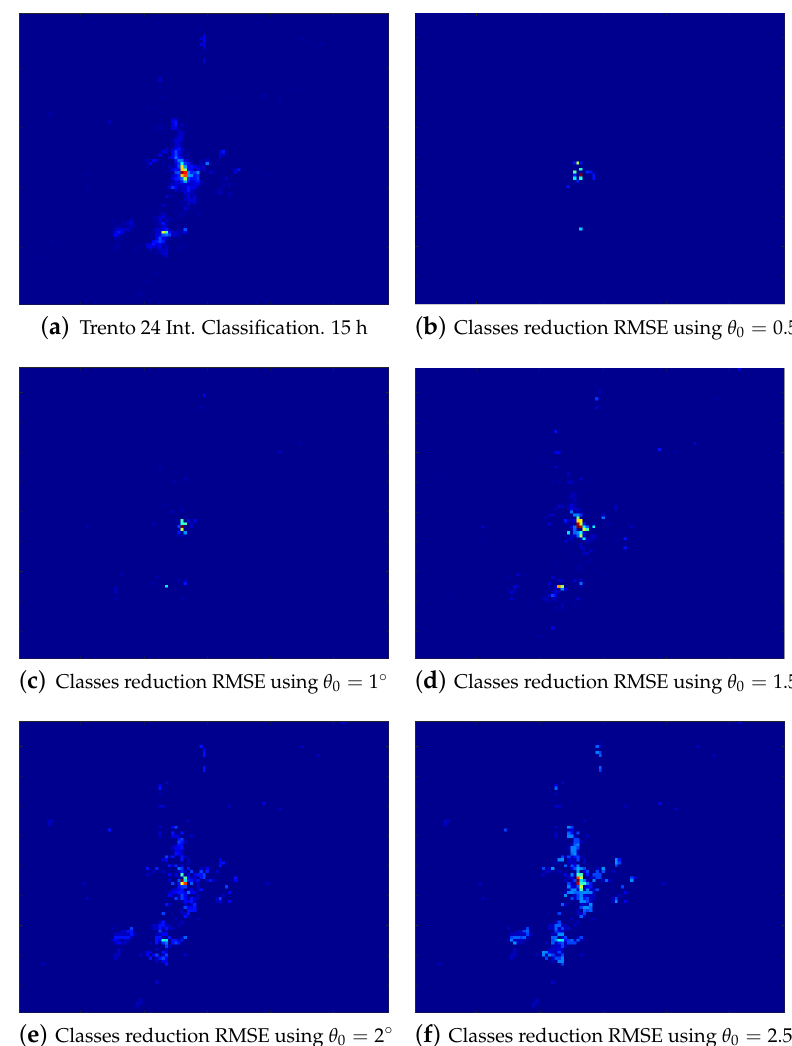
Figure 6. ( a ) The original classification map. ( b – f ) The approximated Root Mean Square Error (RMSE) values after comparing the classifications obtained using several threshold ( θ ) values for the similarity reduction performed in the cluster sets